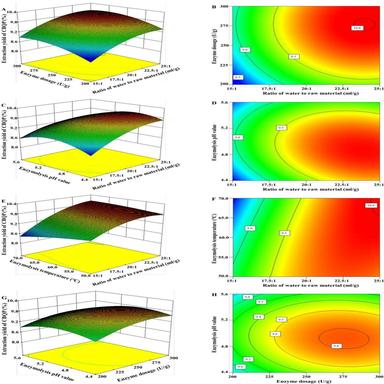
Response surface plots (A, C, E, G, I and K) and contour plots (B, D, F, H, J and L) showing the interactive effects from ratio of water to raw material, enzyme dosage, enzymolysis pH value and temperature, and their mutual effects on extraction yield of CBQP.